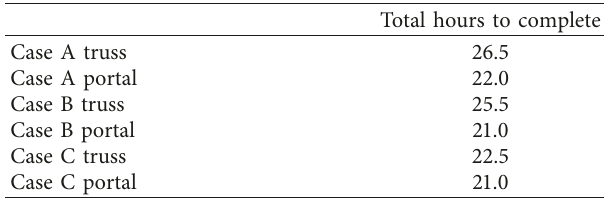
Table 11: Total man hours to